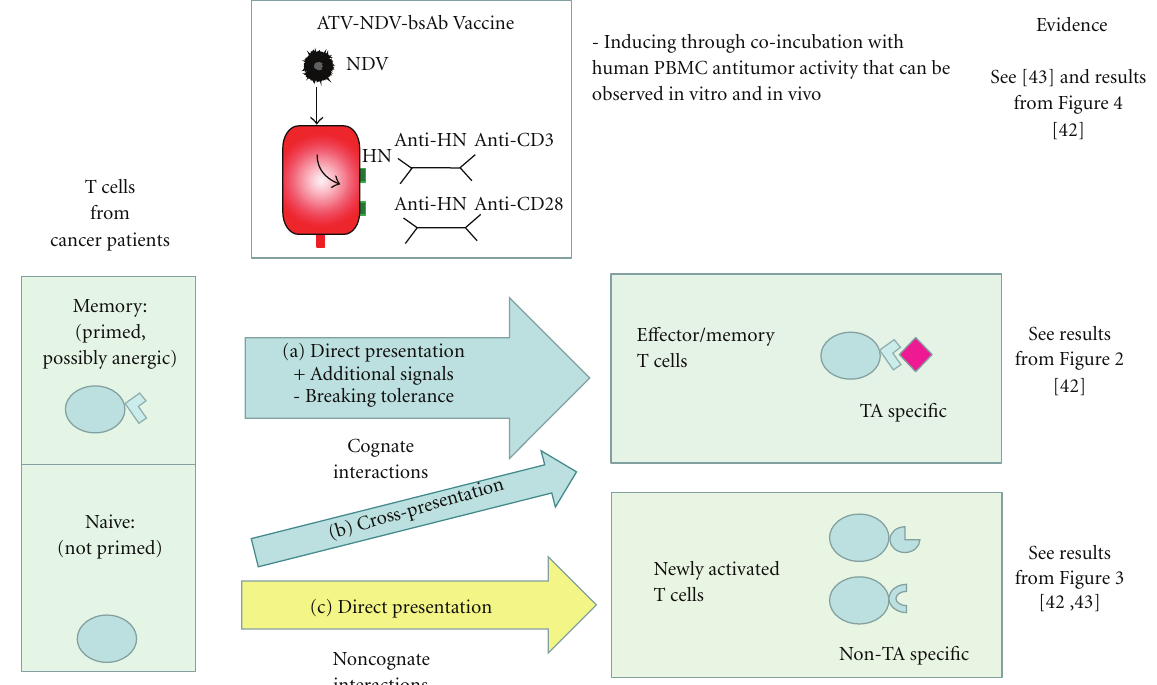
Figure 5: Cognate and noncognate antitumor mechanisms induced by the NDV-based tumor vaccine of the second generation (ATV- NDV/bsAbs). The di ff erent mechanisms of T cell activation against tumor suggested explaining the e ffi cacy of the ATV-NDV/bsAb in inducing antitumor activity in T cells are highlighted. (a) Direct antigen presentation of TA to memory T cells. Addition of danger signals via NDV infection of the tumor cells during the elaboration of the tumor vaccine induces a reactivation of the antitumor reactivity in TA- specific memory T cells [32]. This mechanism is intensified by the addition of the 2 bsAbs introducing binding activities to CD3 and CD28 at the surface of the tumor vaccine (see Figure 2). + signal intensification via bsAb (memory T cells). (b) Cross-presentation via DCs in vivo (naive T cells). (c) Direct polyclonal activation this pathway is highlighted in this manuscript.